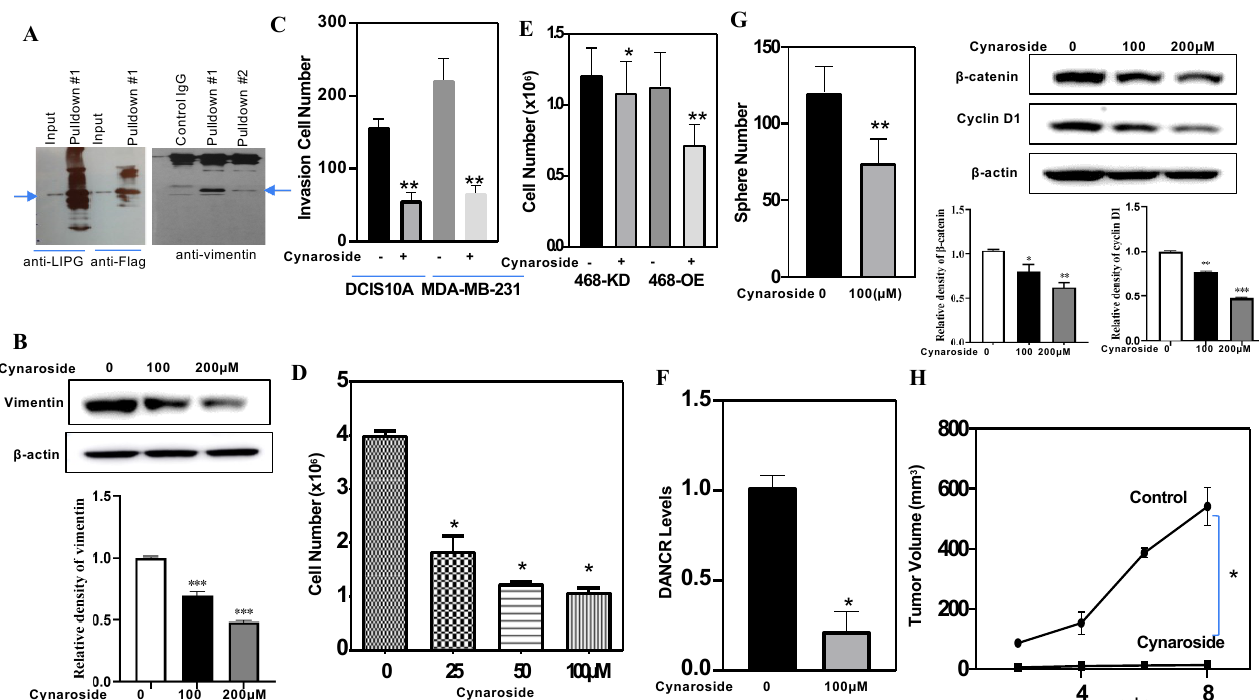
Figure 5. Verification of cynaroside antitumor activity in vitro and in vivo. ( A ) Pulldown assay for LIPG in MCF7OE cells. Anti-flag M2 antibody was used for LIPG pulldown and separated on 10% SDS-PAGE tris-glycine gel. Mouse vimentin antibody was used to detect vimentin. ( B ) MDA-MB-231 cells were treated with 100 µ M and 200 µ M cynaroside for 72 h. Western blotting was performed on whole-cell lysates. Blot quantification is shown below bands, and the uncropped blots are shown in Figure S6. ( C ) DCIS10A and MDA-MB-231 cells were treated with 100 µ M cynaroside for 48 h, and a cell invasion assay was performed. ( D ) 468-OE cells were treated with different concentrations of cynaroside for 72 h. After treatment, cells were stained with trypan blue for cell counting. ( E ) 468-OE and 468-KD cells were treated with 100 µ M cynaroside for 24 h, and cell number was counted. ( F ) qRT-PCR analysis of DANCR in 468-OE cells treated with 100 µ M cynaroside for 72 h. ( G ) Left panel: 468-OE cells were harvested and then replated in the ultra-low attachment well containing the serum-free sphere culture medium with either vehicle or 100 µ M cymaroside for sphere formation. After a week, the numbers of formed tumor-spheres were counted according to the sphere size criterion described [8,10]. Right panel: MDA-MB-231 cells were treated with cynaroside for 72 h, and Western blot was used to measure the proteins as indicated. Blot quantification is shown below bands, and the uncropped blots are shown in Figure S7. ( H ) Fourth mammary fat pads of 2-month-old female nude mice were transplanted with LIPG + IDC breast cancer cells as we previously described [8,10]. After tumor cell transplantation, mice were treated with either vehicle or cynaroside (60 mg/kg, n = 6) for 8 weeks. Animal tumor volumes were recorded and calculated. * p < 0.05; ** p < 0.01; *** p < 0.001. 3.8. LIPG and Vimentin Interaction Facilitates Tumor Cell Invasion, and Cynaroside Inhibits LIPG and Vimentin to Impede Tumor Cell Invasion TNBC cells express higher levels of vimentin, and vimentin knockdown impairs tumor cell migration [50]. Vimentin interacts directly with ubiquilin 2 (UBQLN2)